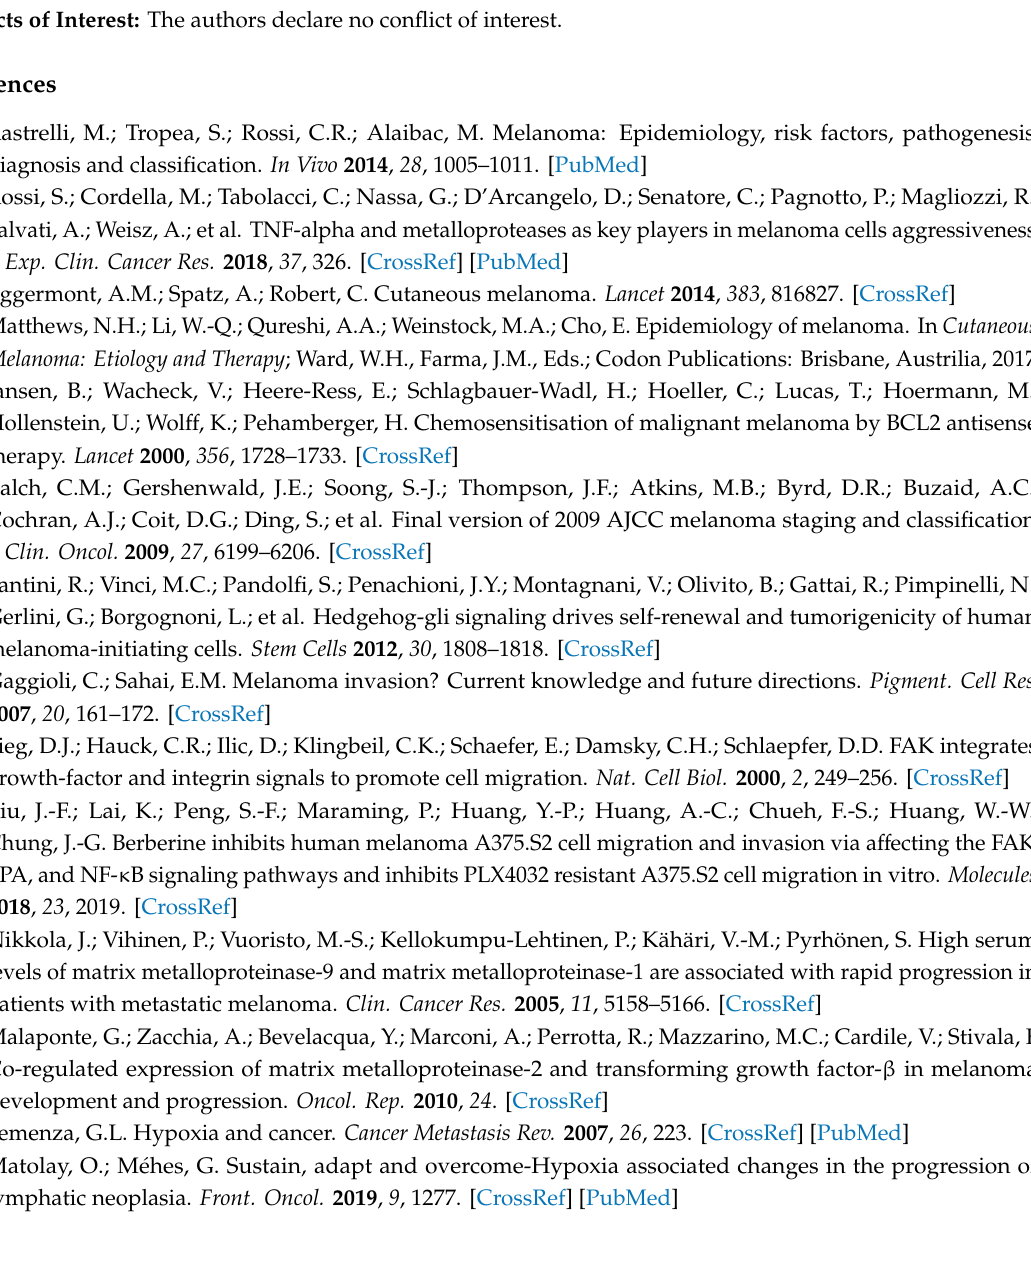
Figure S1: The uncropped blots of Figure 1A,D, Figure S2: The uncropped blots of Figure 2A, Figure S3: The uncropped blots of Figure